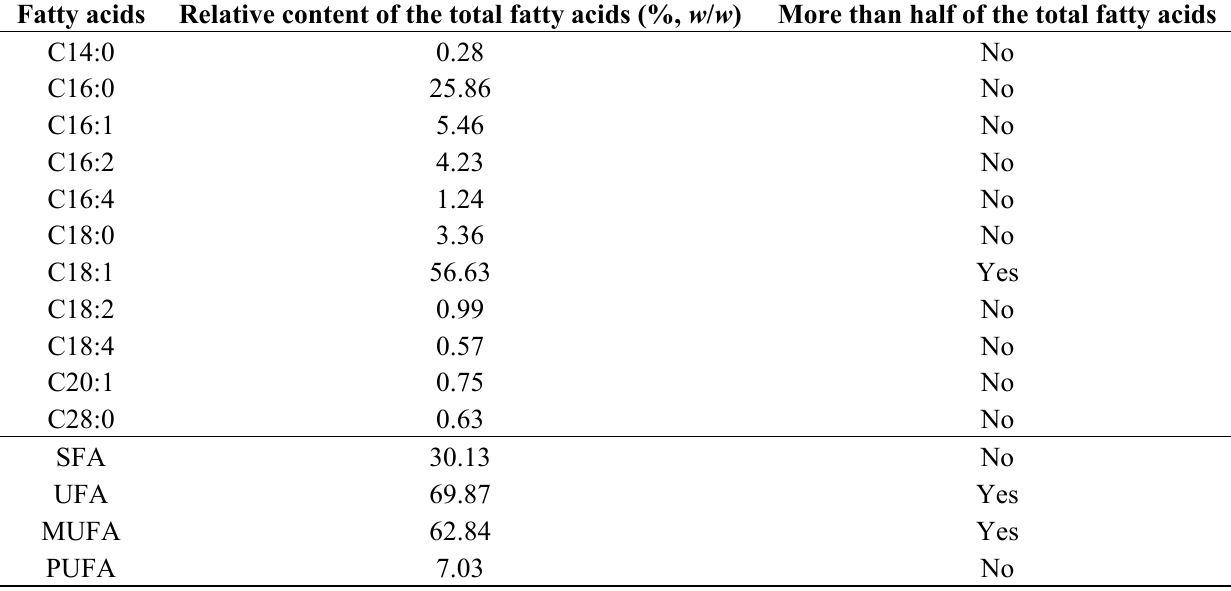
Table 1. Fatty acid composition of Coelastrum sp.